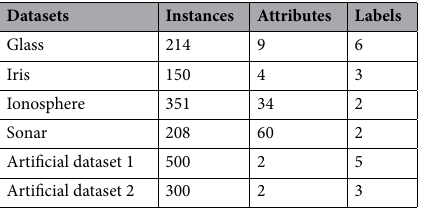
Table 3. Dataset information used in experiments 1, 2, and